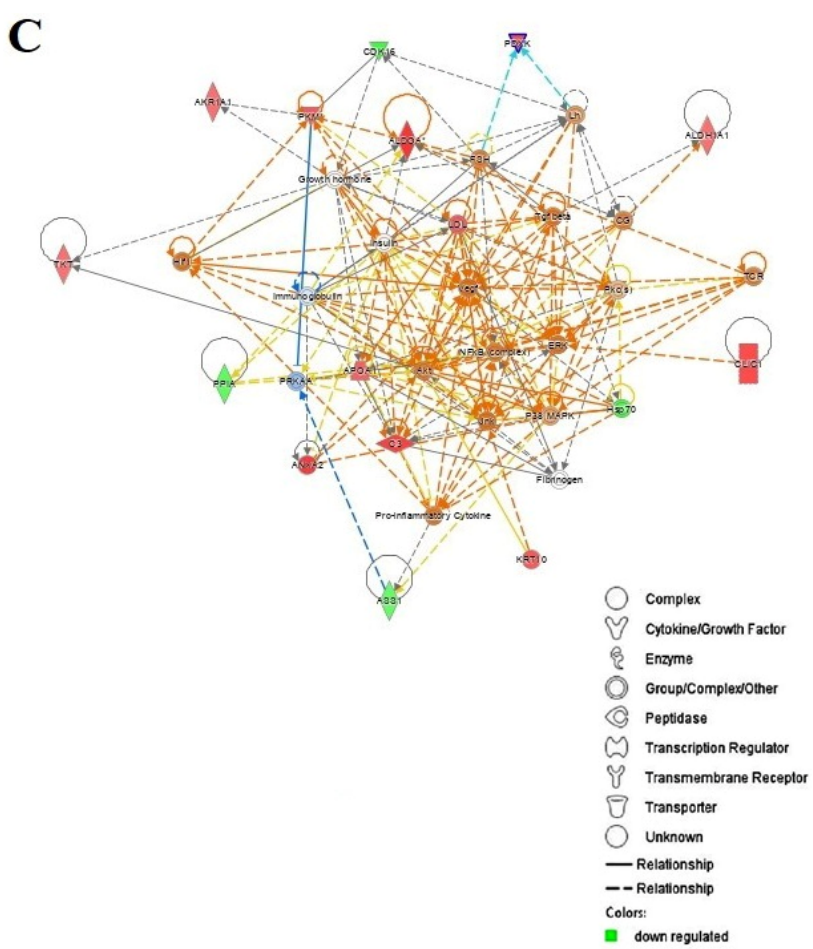
Figure 5. The most enriched interaction network of differentially expressed proteins between the different groups. Red and green nodes indicate up- and downregulated proteins, respectively. Uncolored nodes are proposed by IPA and indicate potential targets that were functionally coordinated with the differentially expressed proteins. Solid lines indicate direct molecular interactions, and dashed lines represent indirect interactions. ( A ) Interaction network of differentially expressed proteins in the EC group compared to the HY group. Central nodes of the pathway related to signaling of ACTA2, AKT, and PI3K were found to be dysregulated between the two states. * appears next to any proteins for which the input file contained more than one identifier ( B ) Interaction network of differentially expressed proteins in the EC group compared to the Ctrl group. Central nodes of the pathway related to signaling of ACTB and ERK1/2 were found to be dysregulated between the two states. ( C ) Interaction network of differentially expressed proteins in the HY group compared to Ctrl group. Central nodes of the pathway related to signaling of VEGF, NFKB, and AKT were found to be dysregulated between the two states.